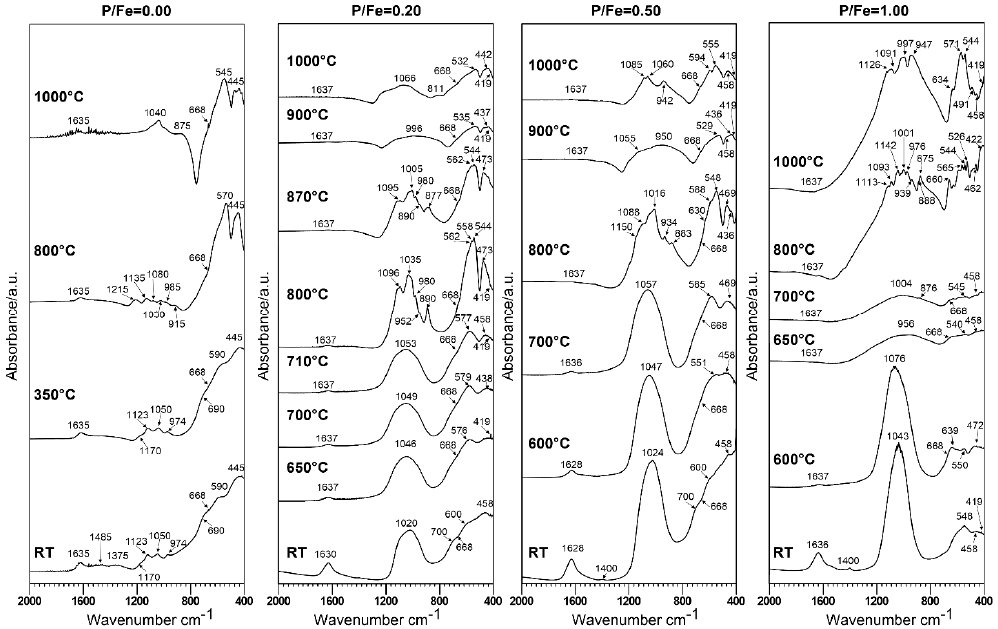
Figure 8. Comparison of background corrected FTIR spectra of P-doped ferrihydrites heated to various temperatures. RT—room temperature.